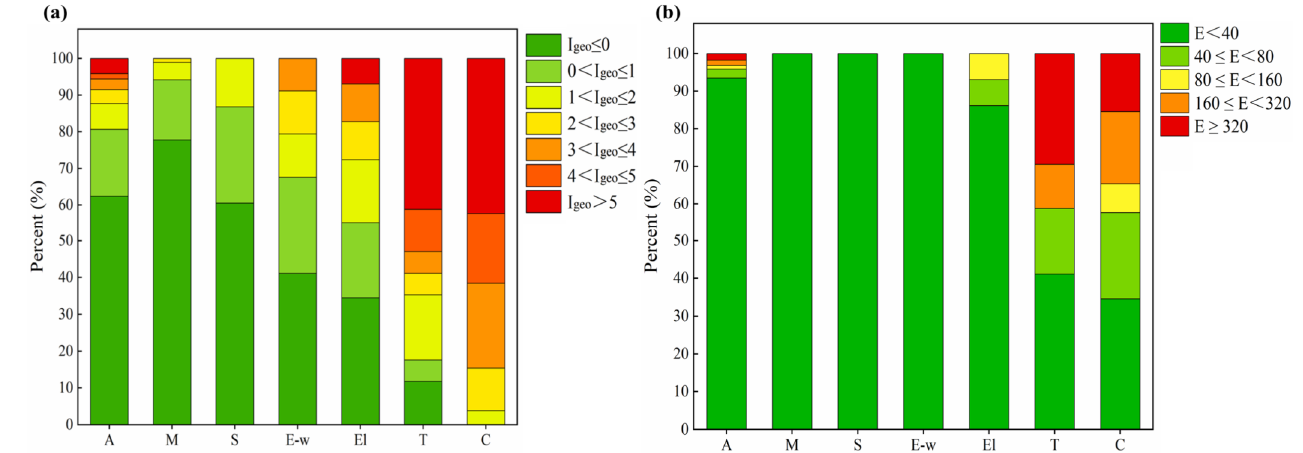
Figure 3. Class distribution of the ( a ) I geo and ( b ) E of all the collected regions and for different region types. (A: all the collected regions; M: mining areas; S: heavy metal processing and smelting areas; E-w: E-waste treatment and disposal sites; El: electroplating sites; T: tanning and the tannery sludge storage sites; C: Cr salt production and chromite ore processing residue disposal areas.).